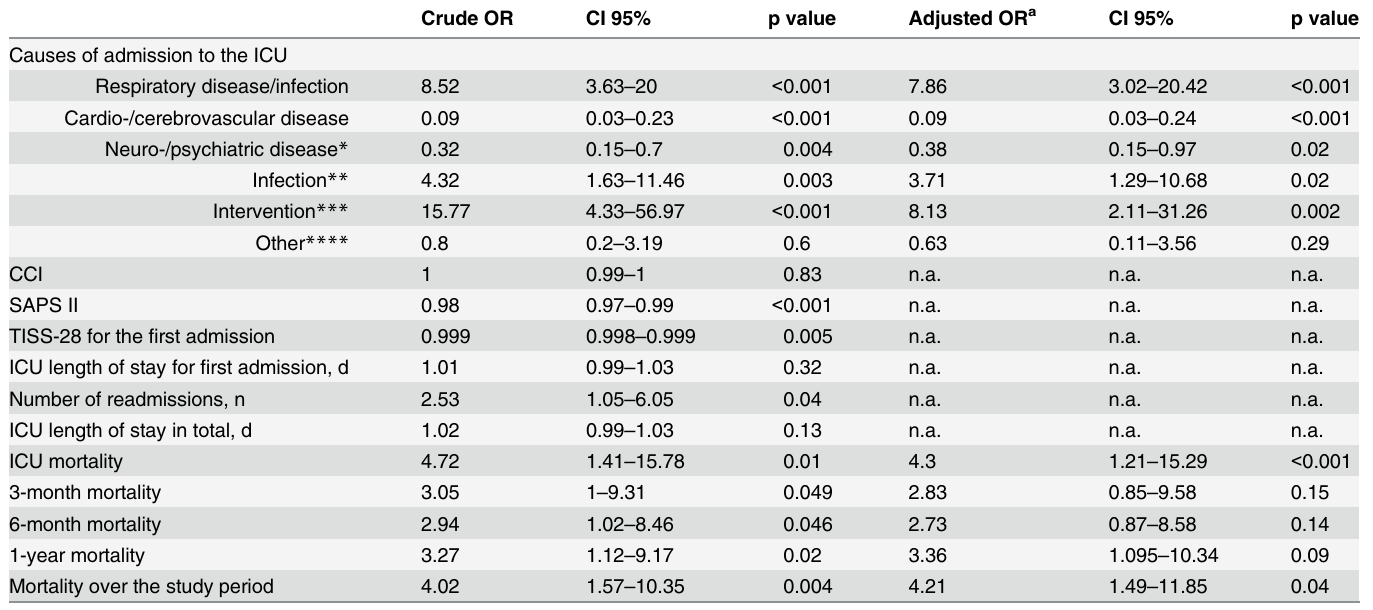
Table 2. Causes of admission, ICU characteristics and mortality in patients with MS and non-MS controls. Crude OR CI